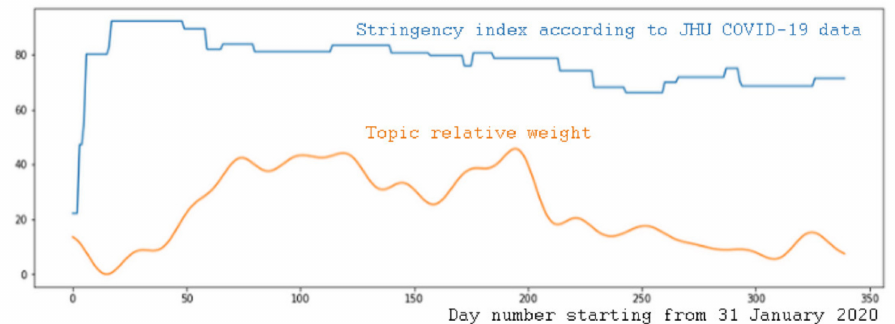
Figure 9. Blue line shows quarantine limitations index in Kazakhstan over time, orange line shows dynamic weight of topic with the highest correlation (0.43) over time. The topic is related to the reports on newly identified COVID-19 cases across the different regions of the